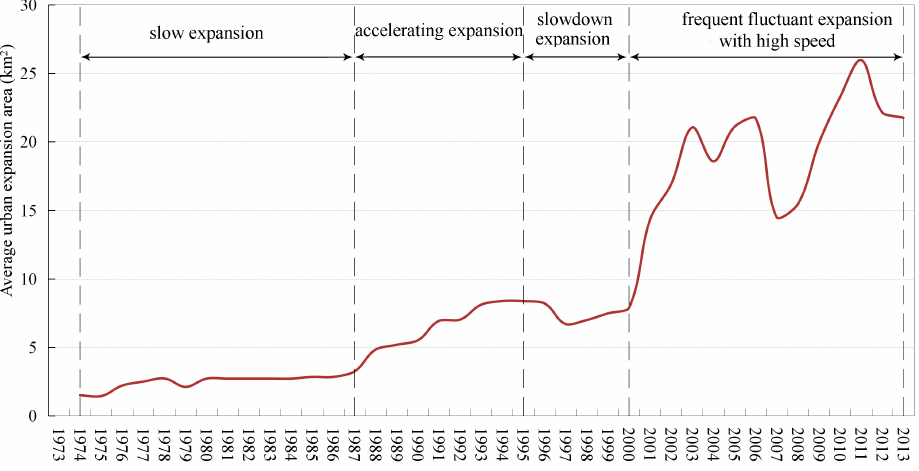
Figure 5. Average urban expansion areas of the 31 sample cities from the 1970s to 2013.